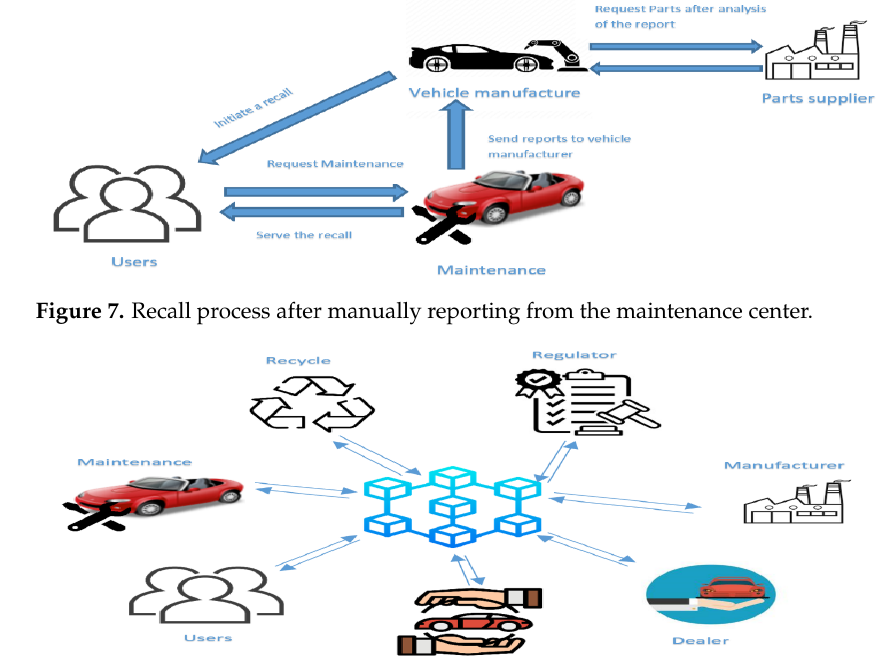
Figure 8. Blockchain distributed system in smart cities for automotive industry.